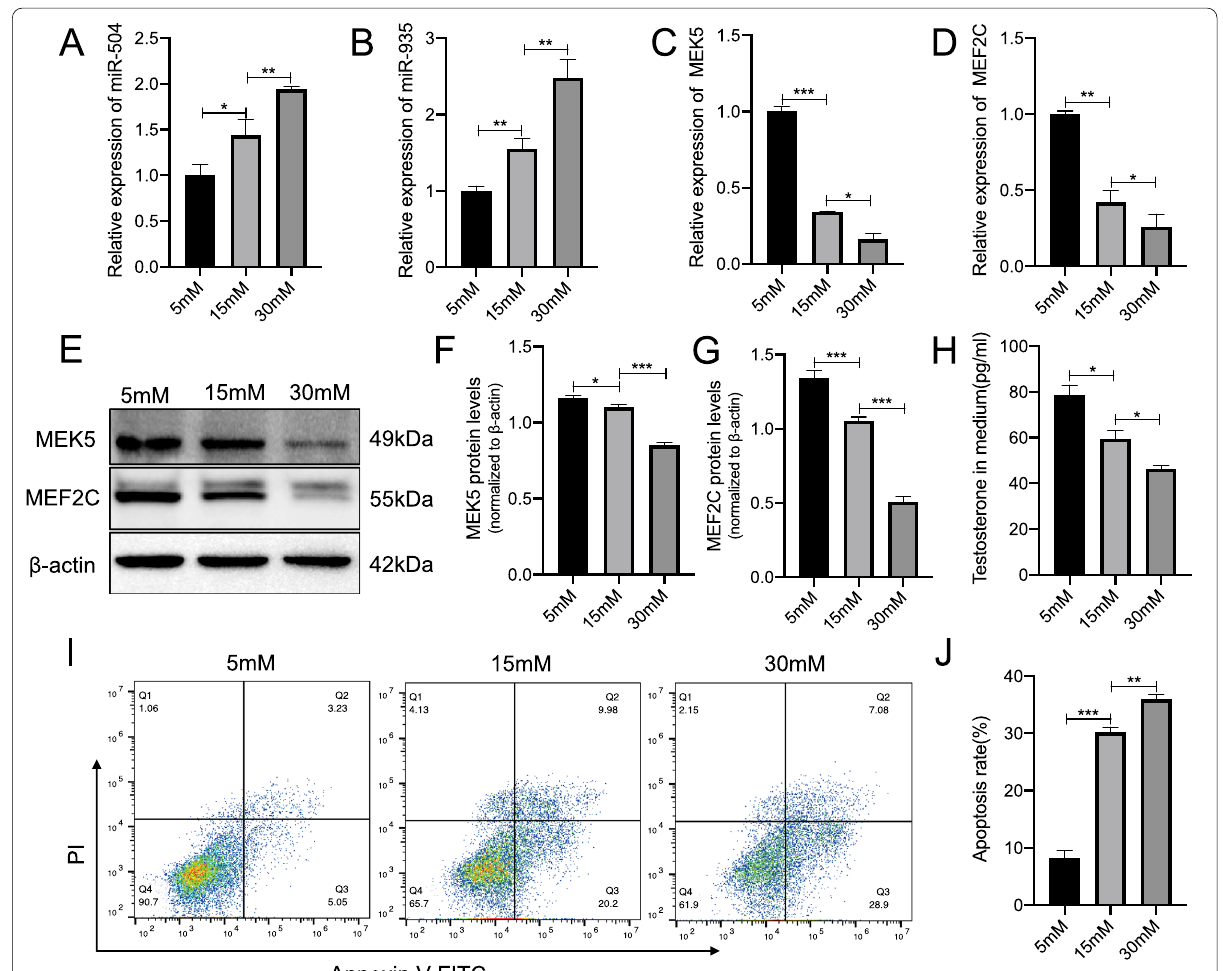
Fig. 4 Effect of glucose concentration on miRNAs and apoptosis. Expression of miR-504 ( A ) and miR-935 ( B ) in R2C cells at 24 h after culturing in a glucose concentration gradient (basal glucose for R2C cell was 5 mM and stimulated concentrations were 15 mM and 30 mM). Data were normalised to U6 RNA, used as an internal control. Expression of MEK5 ( C ) and MEF2C ( D ) determined using RT-qPCR analysis. β-actin was used as an internal control. Representative immunoblotting ( E ) and cumulative quantification of the protein levels of MEK5 ( F ) and MEF2C ( G ) in R2C cells. Media were collected and assayed for concentration of testosterone using ELISA ( H ). Detection of apoptotic cells using FACS analysis with FITC-labelled annexin V and PI staining ( I ). Bar graphs represent the percentage of apoptotic cells in each group ( J ). *p < 0.05, **p < 0.01, ***p < 0.001. n =